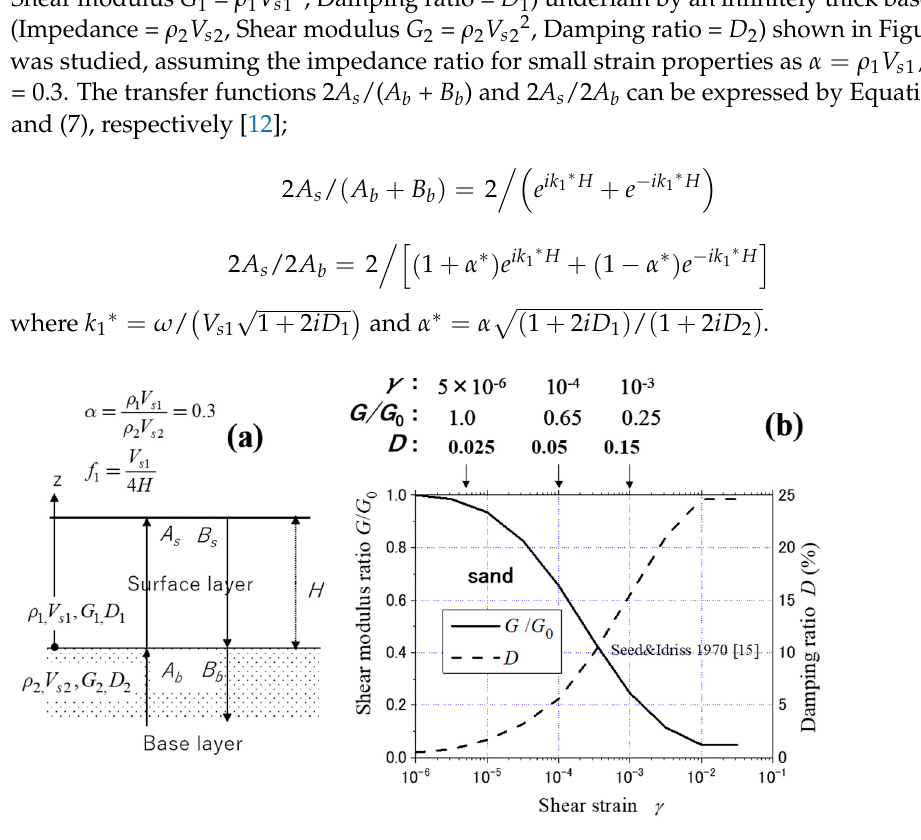
Figure 15. Calculated transfer function of two-layers model at three strain levels: Horizontal array (2 A s /2 A b ) ( a ), and Vertical array (2 A s /( A b + B b )) ( b ). Obviously, nonlinear soil properties have a great effect on peak frequency and amplification. In particular, the peak frequency becomes evidently lower with modulus degradation both in 2 A s /( A b + B b ) and 2 A s /2 A b . However, with regard to peak amplification,